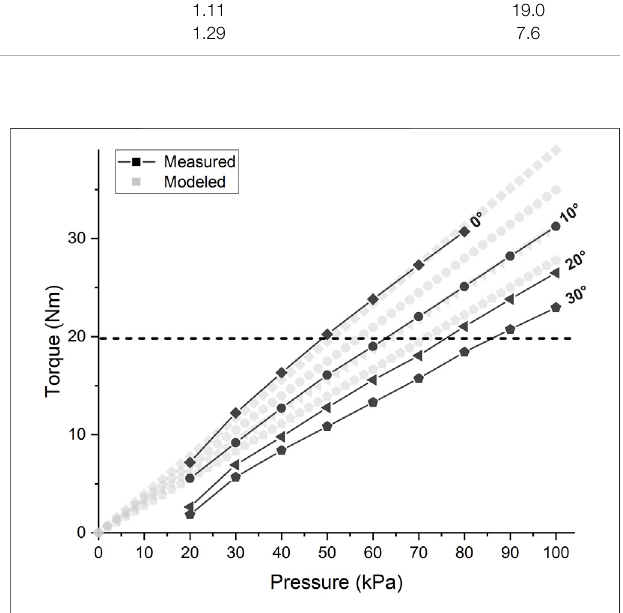
FIGURE 7 | Torque Test Results: Torque vs. Pressure of SWAG actuation system. Horizontal dashed line indicates target torque output of 19.8